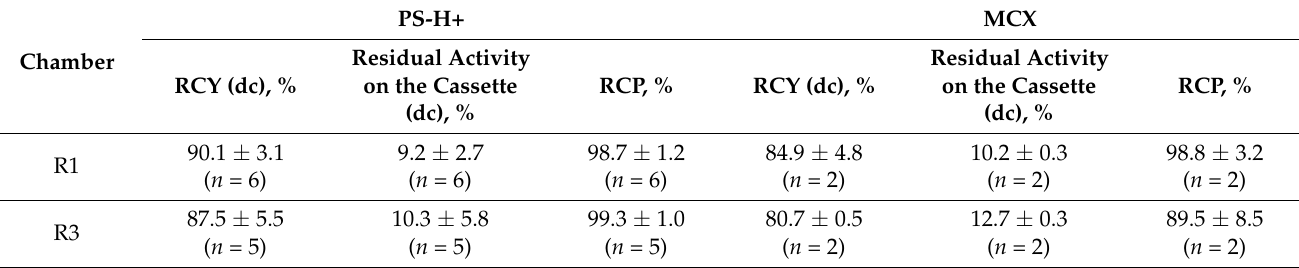
Table 4. Radiochemical yields, purity, and residual activity values for [ 68 Ga]Ga-citrate